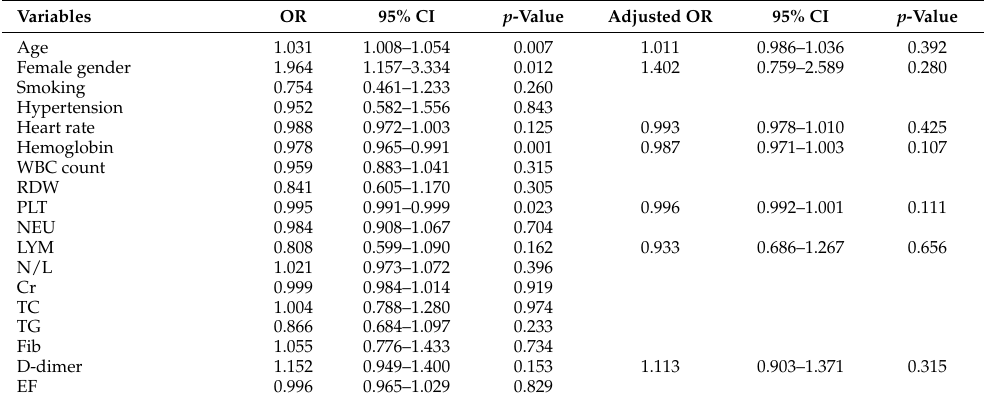
Table 5. Logistic regression analysis of predictors of no-reflow in the No-DM population.